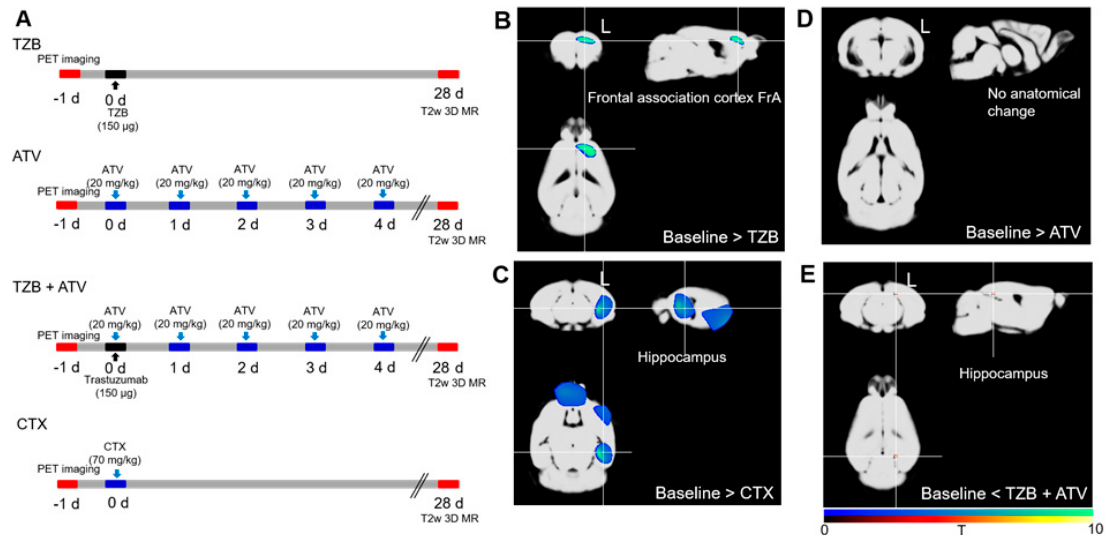
Figure 2. MR VBM evidence of ATV effect during TZB therapy. ( A ) The experimental design. ( B ) A decrease in gray matter concentration was observed in the region of the left frontal association cortex during TZB therapy and in the region of the frontal association cortex and hippocampus on the left side. ( C ) During CTX therapy relative to the baseline ( p < 0.005). ( D ) No significant difference between ATV and the baseline was observed ( p < 0.005). ( E ) Decreased regional gray matter concentration in the region of the frontal association cortex during TZB therapy was rescued when ATV was administered ( p < 0.005). MR, magnetic resonance imaging. T2w, T2-weighted imaging. 3D, three-dimensional. VBM, voxel-based morphometry. ATV, atorvastatin. TZB, trastuzumab. CTX, cyclophosphamide. ( n = 7 per group).